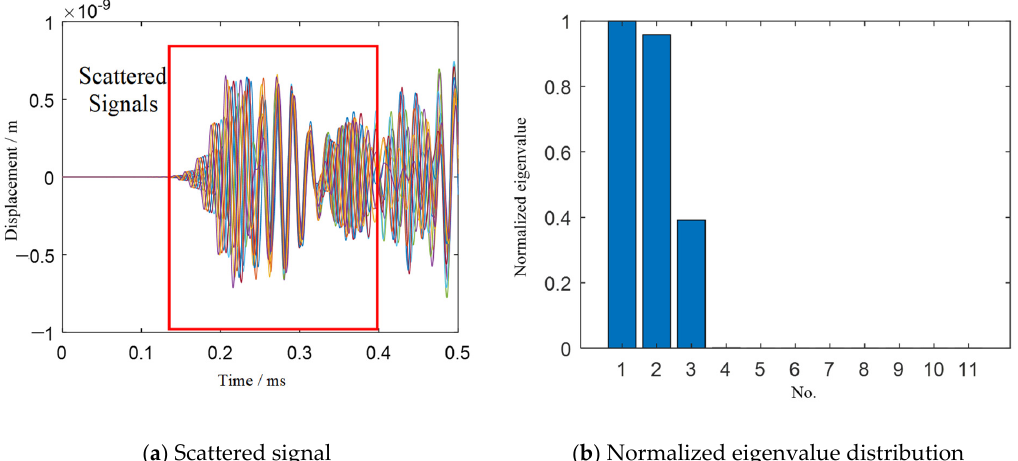
Figure 8. Scattered signals and eigenvalue distribution of three damage for TR ‐ MUSIC.